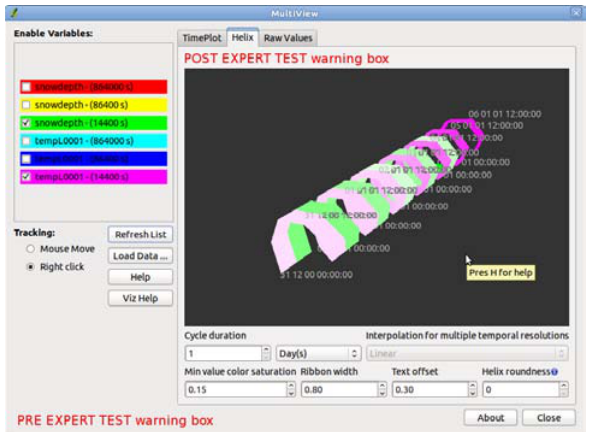
Figure 5. The helix view showing multiple cyclic phenomena 1